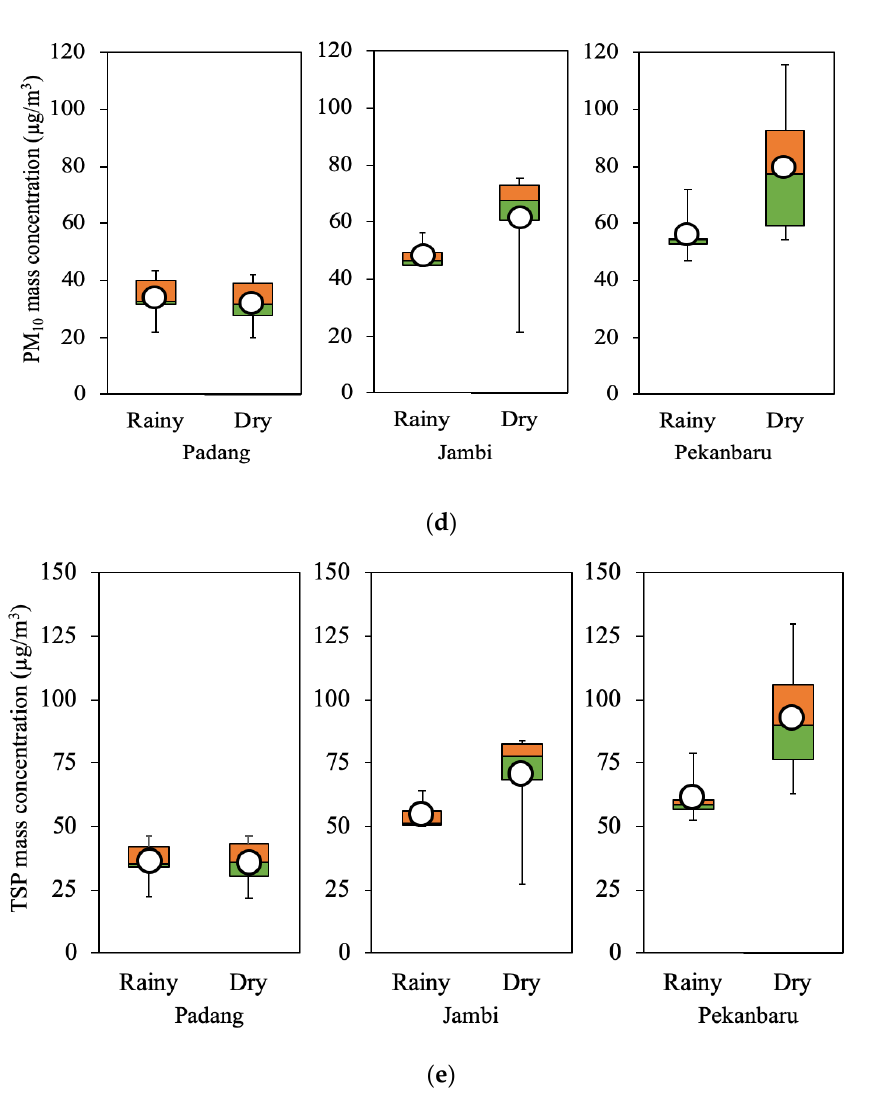
Figure 2. Seasonal particle mass concentrations in Sumatra island, Indonesia: ( a ) PM 0.1 , ( b ) PM 1 , ( c ) PM 2.5 , ( d ) PM 10 , and ( e ) TSP.